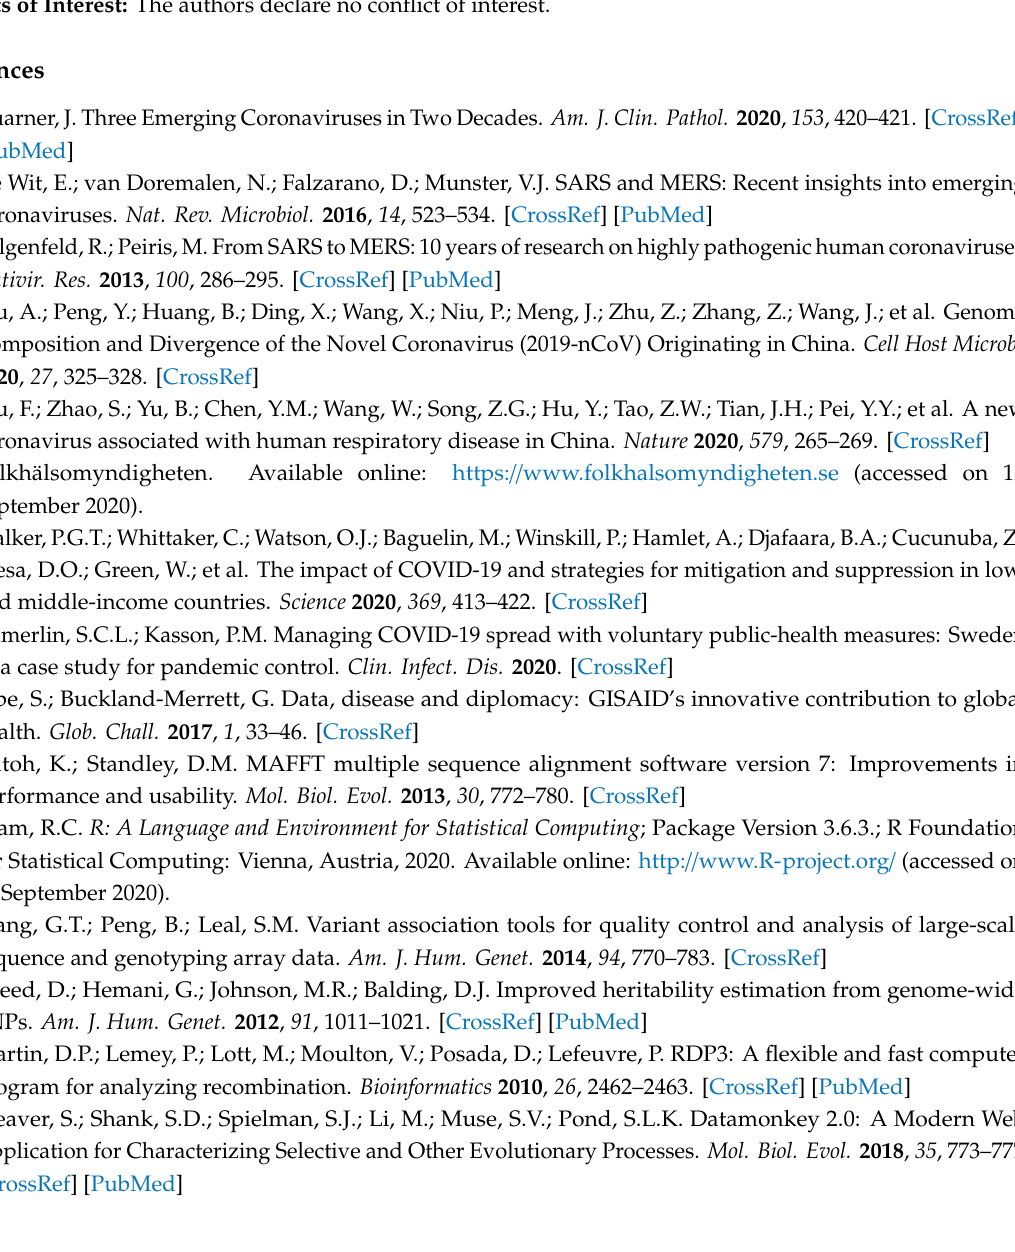
Figure S1. (a) Longitudinal cumulative mutational profile frequency of the sequenced Swedish strains. (b) Mutational profile preference indicated by months and locations. Figure S2. Maximum-likelihood phylogenetic tree of SARS-CoV-2. The taxa color in red represents the variants from Wuhan and blue are from Sweden. Table S1. Spatial temporal appearance of each variant and their mutation profile and clade information. Table S2. Model comparison by BEAST